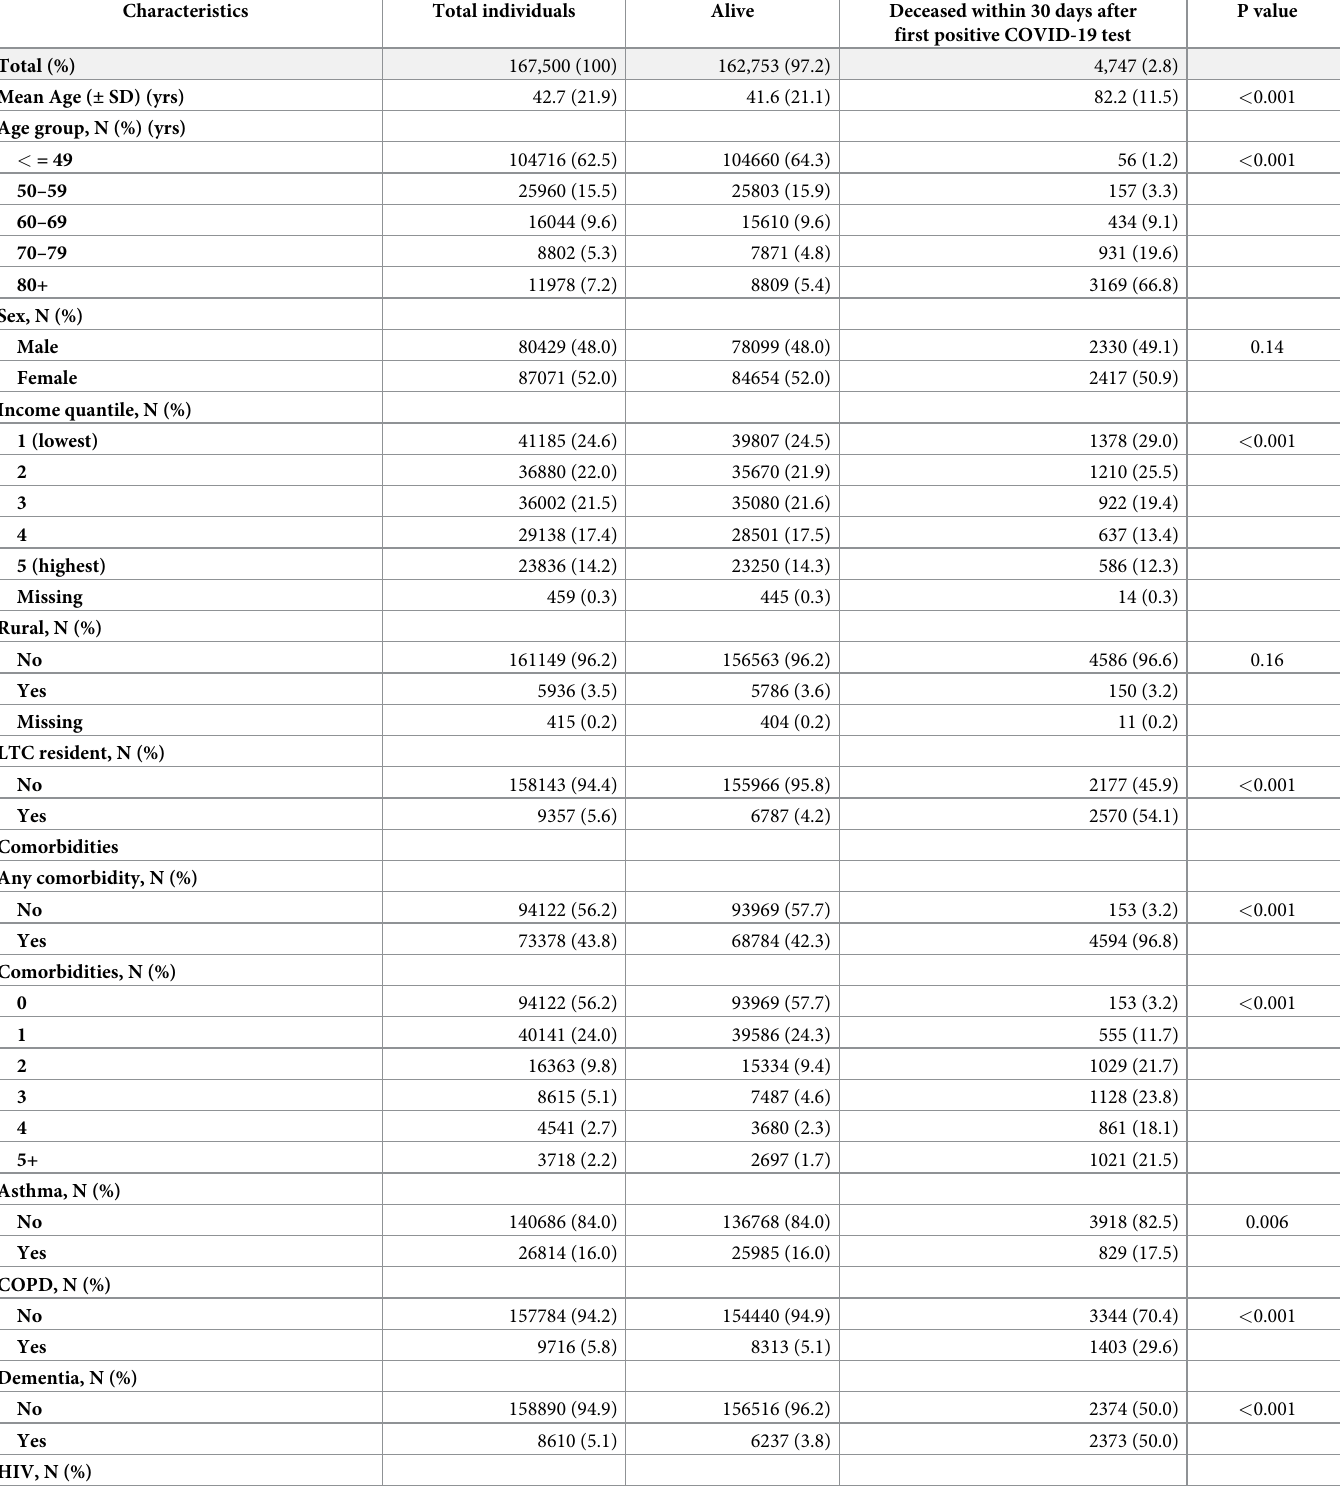
Table 1. Characteristics of individuals with COVID-19 in Ontario, Canada by December 31,